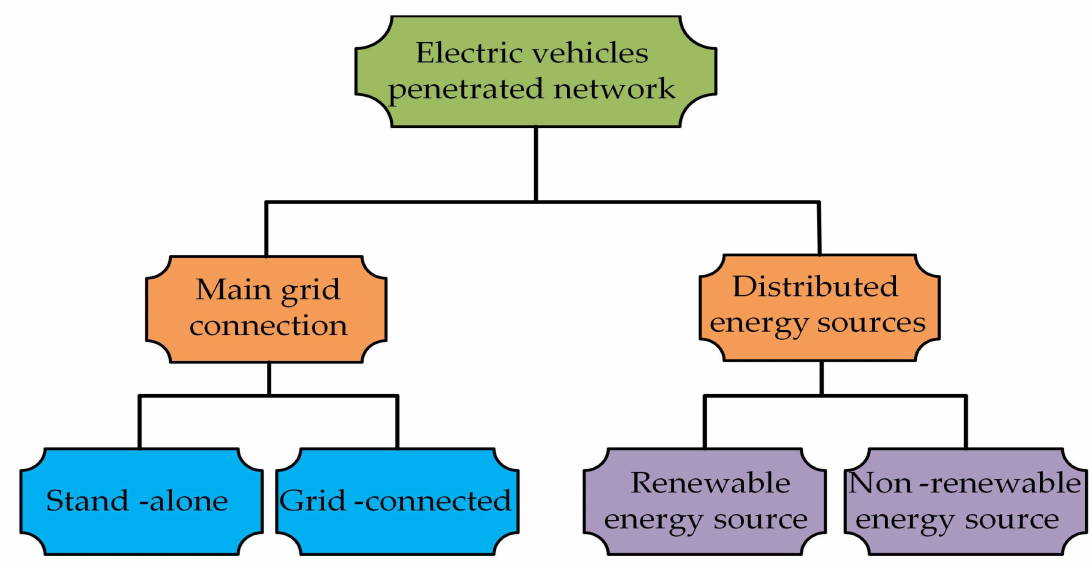
Figure 9. Penetration of EVs in main power grids and distributed energy sources.